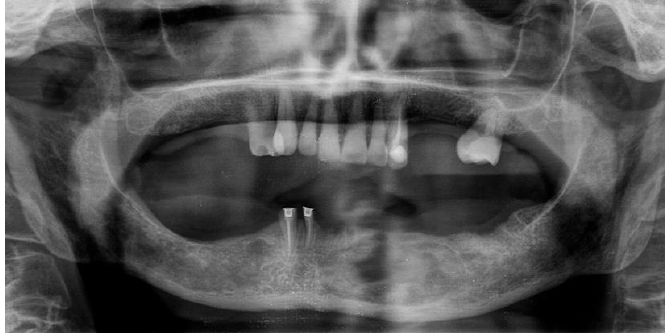
Figure 10. Two-year post operatory control OPG. Figure 9. Two-year post operatory control